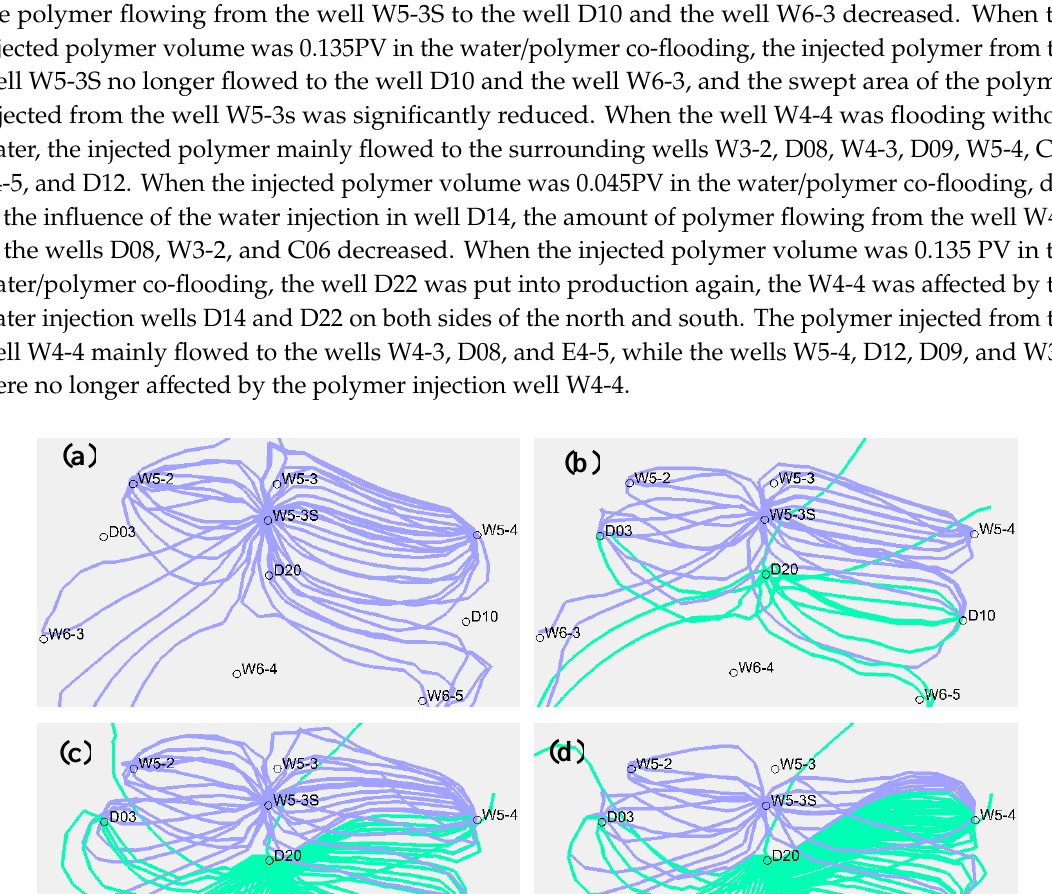
Figure 9. The streamline field of the ( a ) initial and ( b ) injected polymer 0.1 PV in the water/polymer flooding stage.